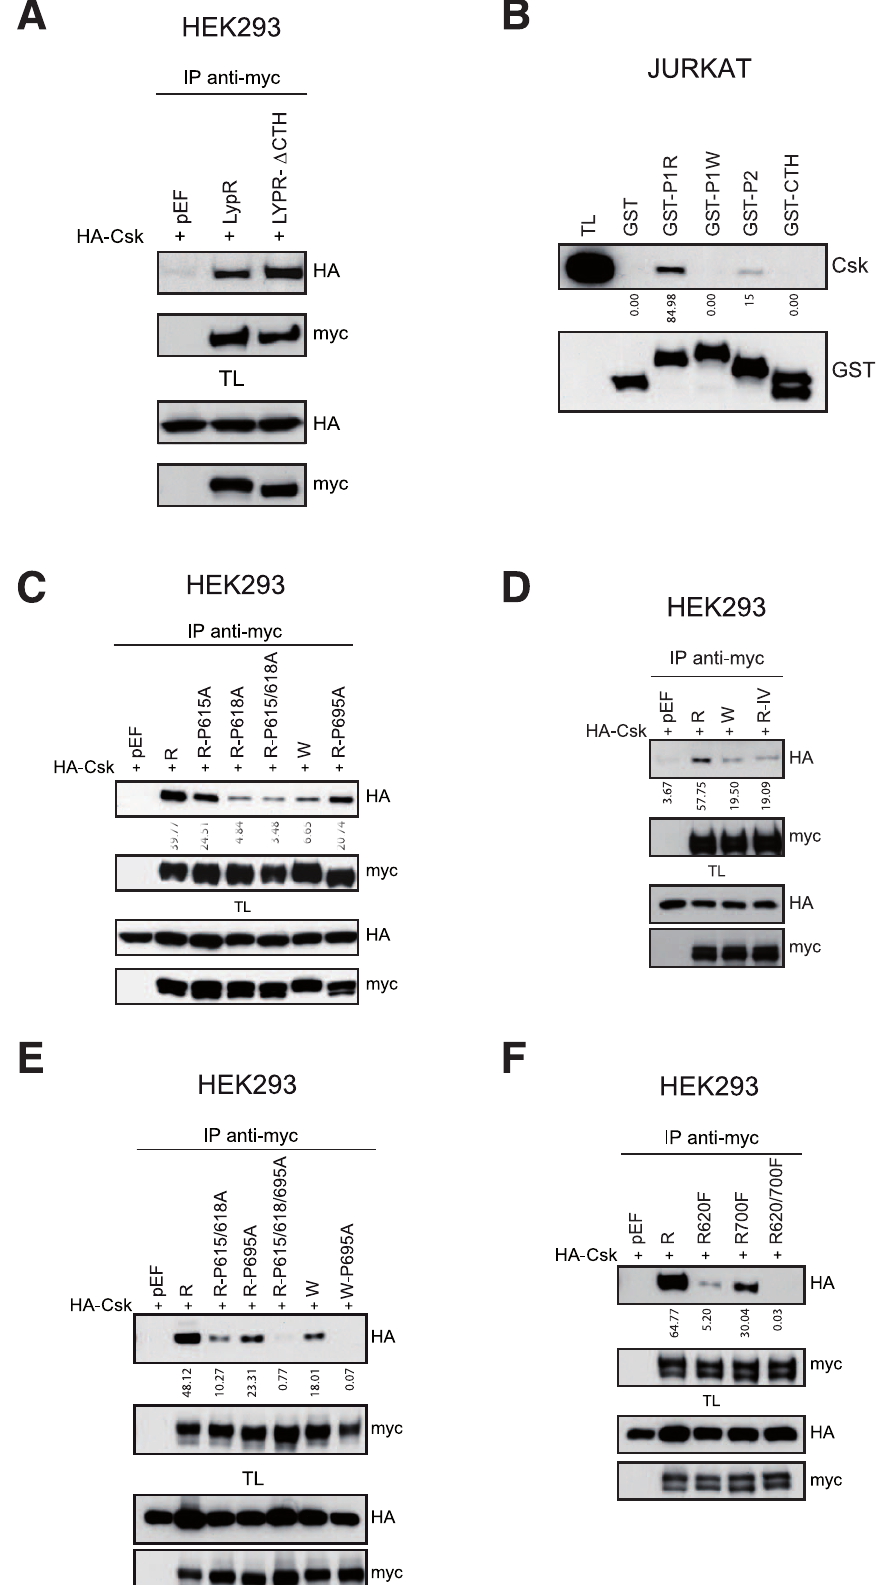
Figure 2. P1 and P2 LYP motifs bind to CSK. A , Lysates of HEK293 cells transfected with LYP and a deletion mutant of LYP tagged with the myc epitope that lacks the CTH PRM, tagged with the myc epitope, along with HA-CSK plasmids were immunoprecipitated and immunoblotted with the